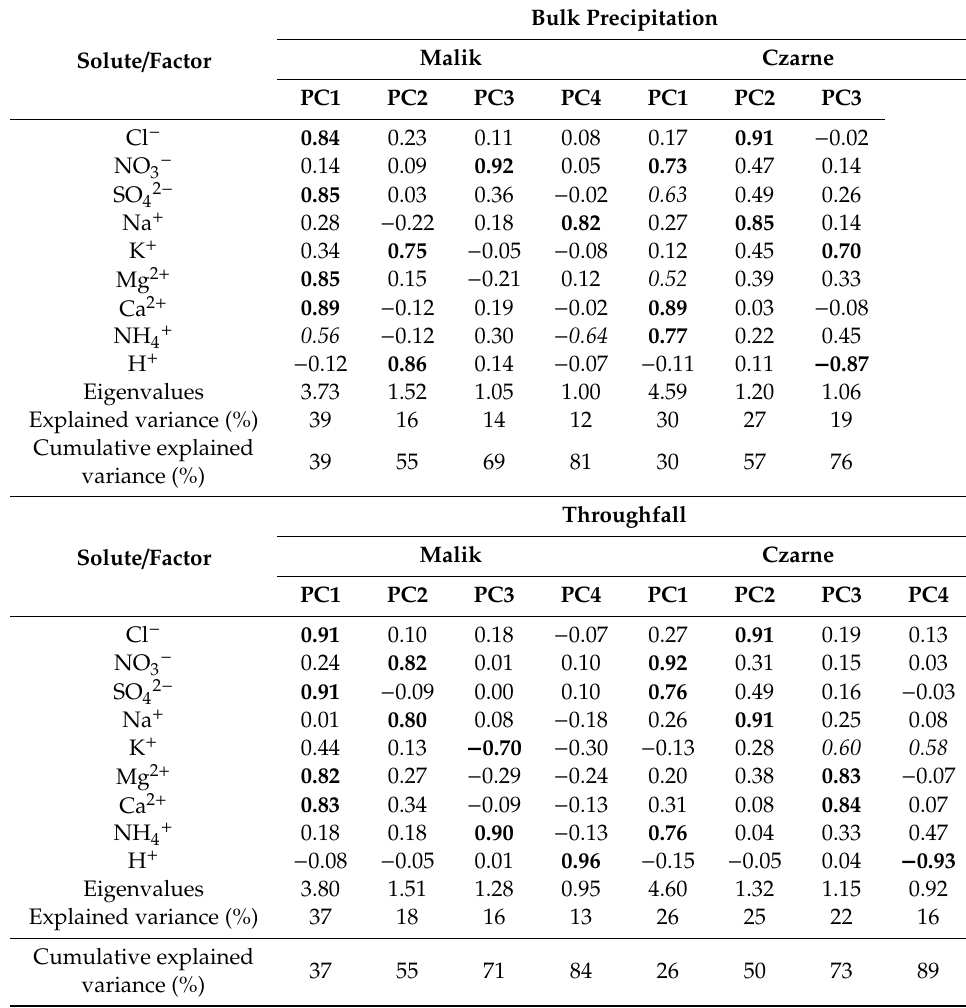
Table 6. Factor loading and explained variance for bulk precipitation (BP) and throughfall (TF). Bulk Precipitation Malik Czarne Solute / Factor